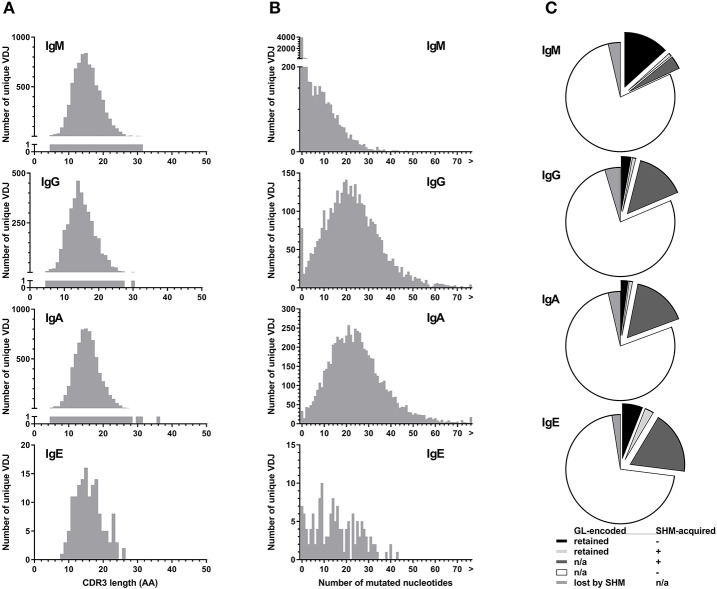
Parameters of BCR hypervariability. (A) Comparison of CDR3 length between isotypes. The number of unique VDJ sequences with a given CDR3 amino acid (AA) length as defined by IGMT HighV-Quest is shown per isotype. (B) Comparison of somatic hypermutation between isotypes. The number of unique VDJ sequences with a given number of nucleotide changes compared to their most closely related germ-line IGHV sequence is displayed per isotype. Sequences longer than 75 bp are indicated by “>”. (C) Fractions of VDJ sequences with N-glycosylation motifs per isotype. Fractions indicate the origin of the N-glycosylation motifs and whether a germ-line (GL)-encoded motif was lost by somatic hypermutation (SHM).